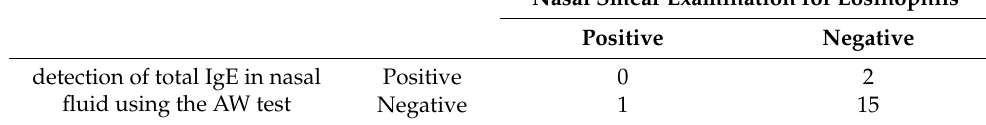
No. 1 Naso-ocular symptoms score: no significant differences in sneeze ( p = Table 1. Comparison of the sensitivity and specificity for the diagnosis of allergic rhinitis (AR) between the detection of total IgE in nasal fluid using the AW test and the conventional nasal smear examination for eosinophils.